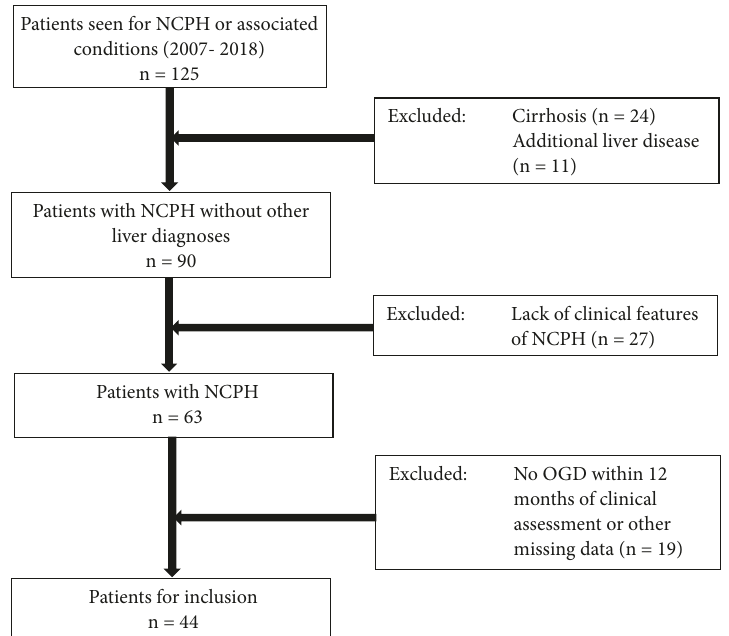
Figure 1: Flow chart of patients evaluated for inclusion in the study. NCPH, non-cirrhotic portal hypertension; OGD, oesophogastroduo-